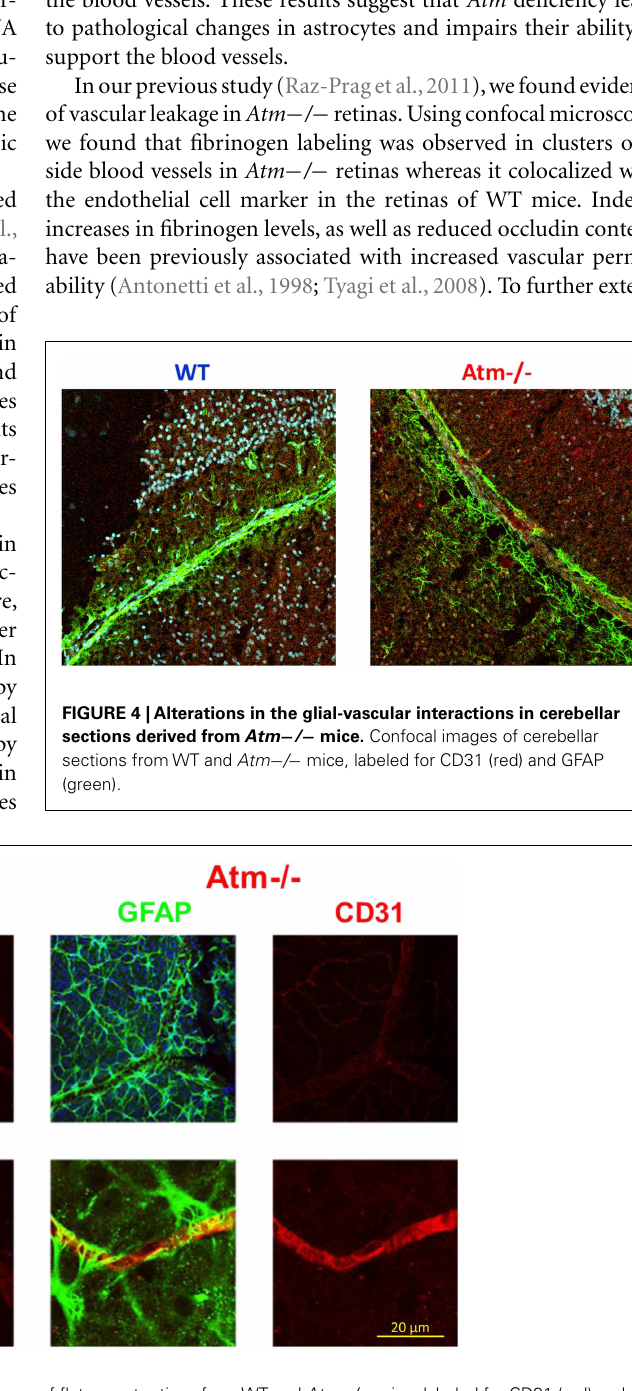
FIGURE 3 | Glial cell alterations in retinas of Atm − / − mice. Confocal images of flat-mount retinas fromWT and Atm − / − mice, labeled for CD31 (red) and GFAP (green). Magnification: × 4.